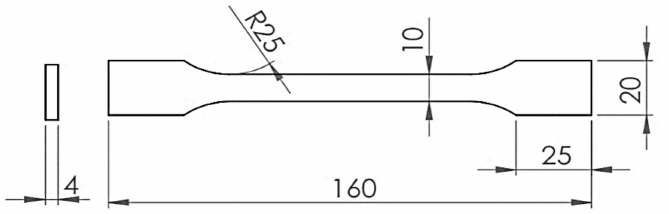
Figure 1. Dogbone dimensions in